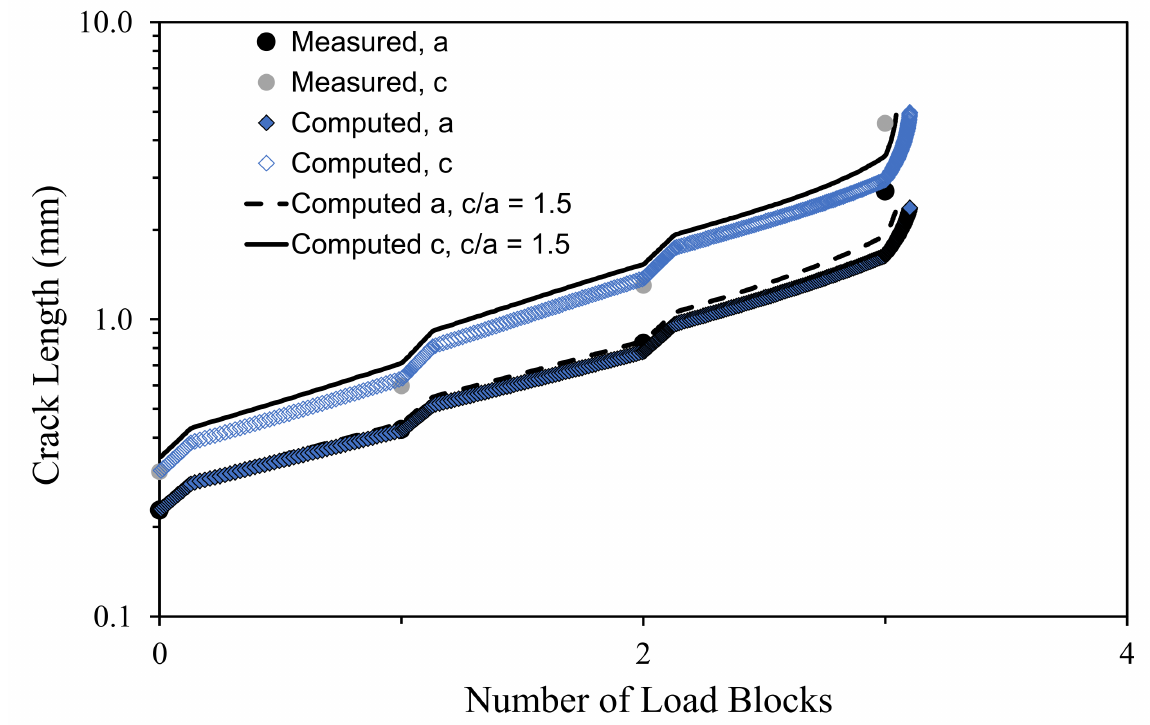
Figure 16. The measured and computed crack depth/length